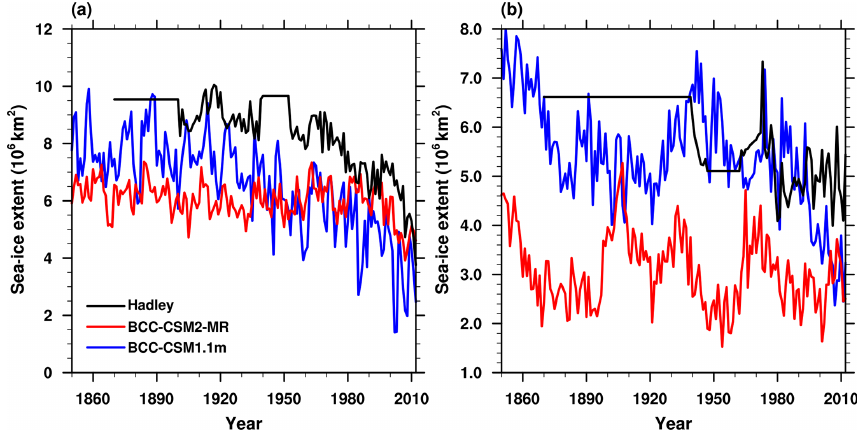
Figure 14. Time series of the sea-ice extent from 1851 to 2012 for (a) the Arctic in September and (b) the Antarctic in March as simulated in BCC-CSM2-MR and BCC-CSM1.1m in addition to observations derived from the Hadley Centre Sea Ice and Sea Surface Temperature data set (Rayner et al., 2003).